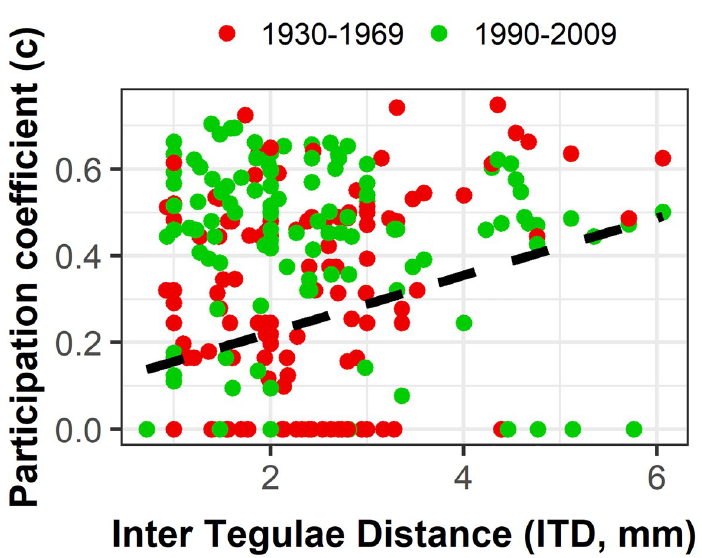
Fig 3. Distribution of intertegular distance according to participation coefficient of bee species. Intertegular distance (ITD, mm) of bee species according to their c -coefficient by period (red: 1930–1969; green: 1990–2009). The dashed line is a quantile regression line